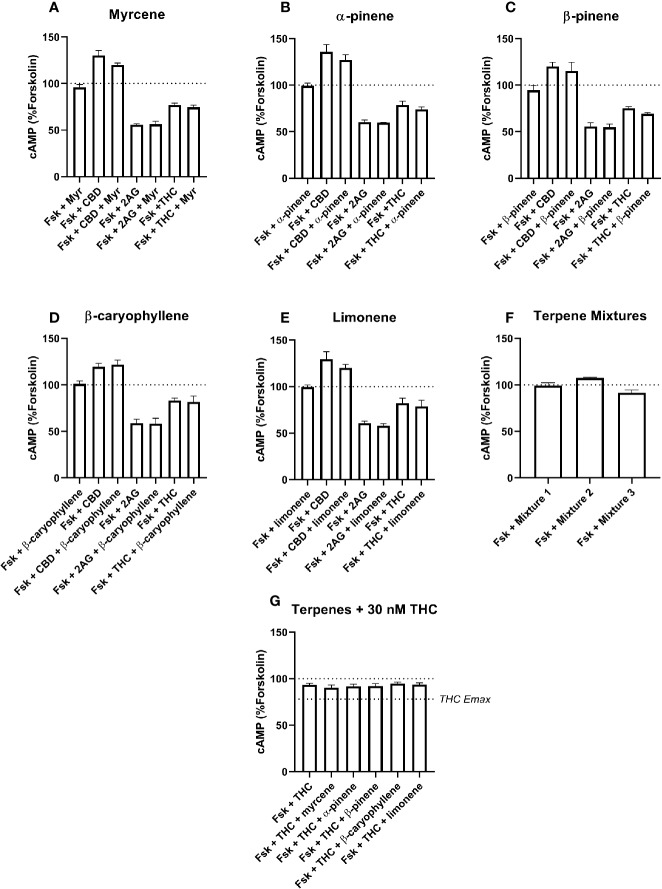
hCB2-Mediated inhibition of cAMP production in response to forskolin (Fsk) and drug combinations with 10 µM myrcene (A), α-pinene (B), β-pinene (C), β-caryophyllene (D), limonene (E), or terpene mixtures (F). Figure (G) shows inhibition of the Fsk response by an approx. EC50 concentration of THC (30 nM) in combination with 10 µM of each of the five terpenes. Data are normalized to forskolin (100%) and basal (0%). cAMP responses were stimulated with forskolin (5 µM), and all cannabinoids and terpenes were at a final concentration of 10 µM. Data are means ± SEM of three independent determinations.